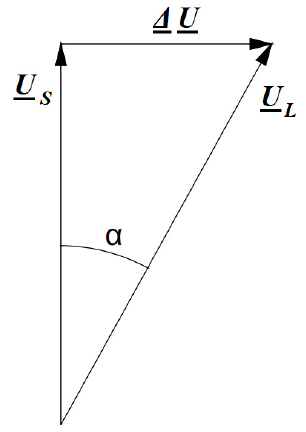
Figure 4. APST voltage phasor diagram.